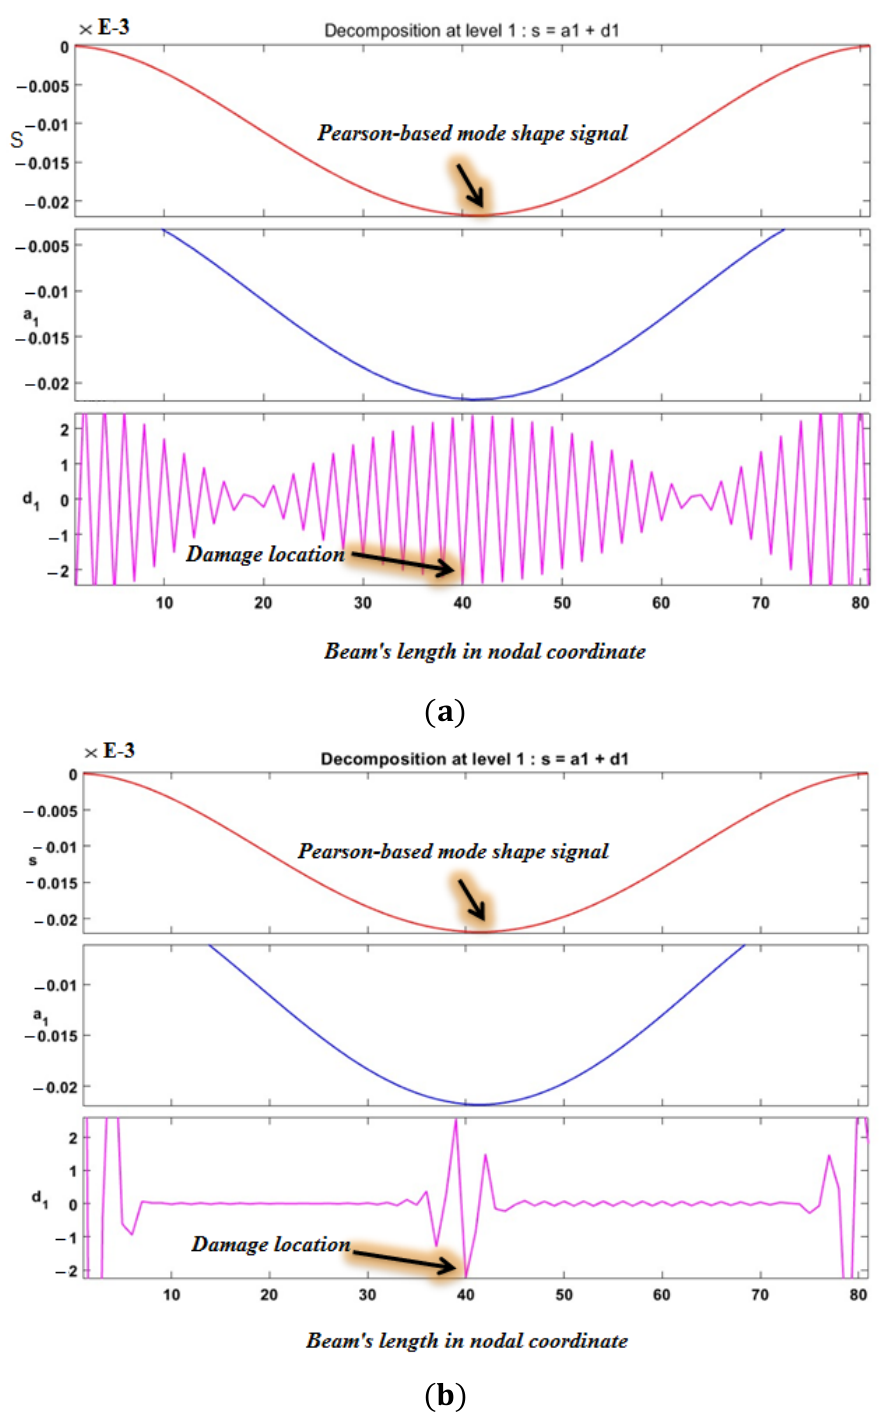
Figure 12. The effect of increasing the vanishing moments on the accuracy of damage detection by 1D-DWT from the quasi-Pearson-based coefficient extracted from intact and damaged mode shapes by 10% damage: ( 𝐚 ) vanishing moments = 2, ( 𝐛 ) vanishing moments = 5.